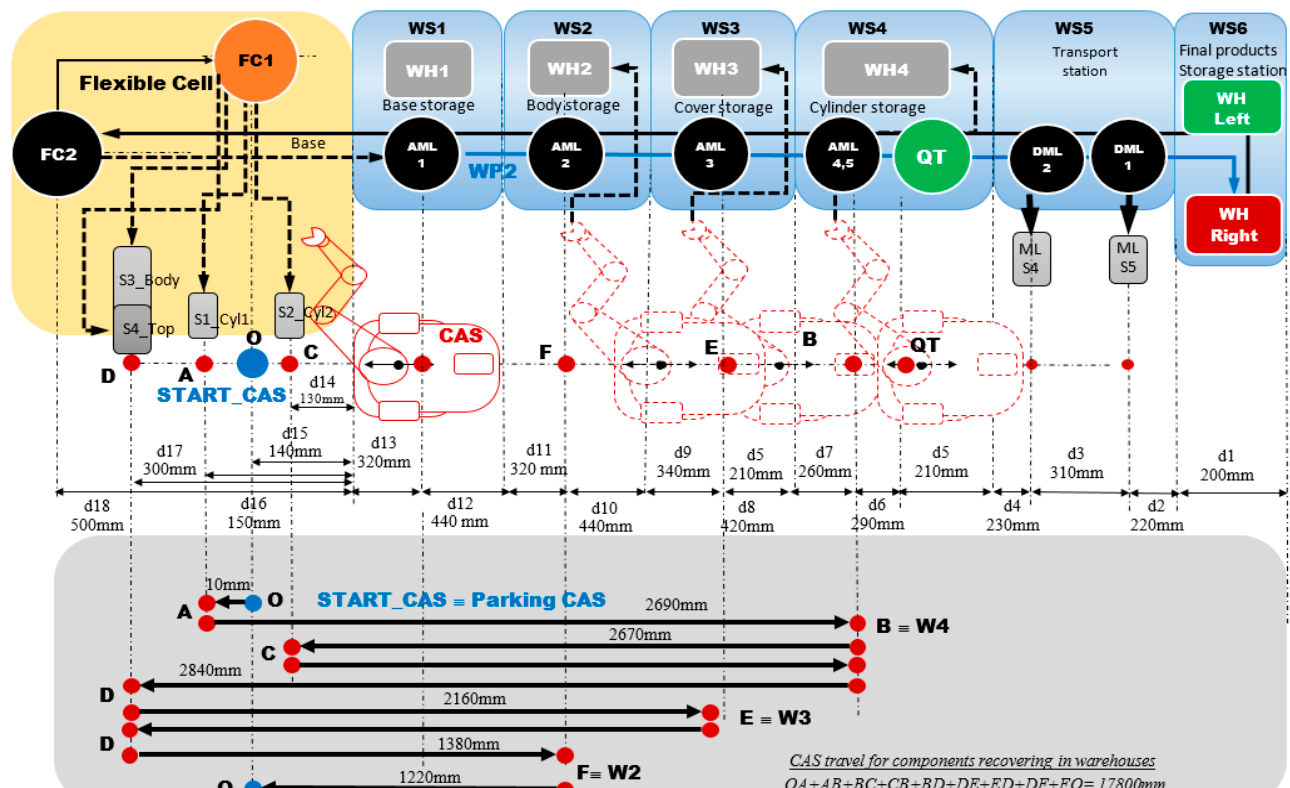
Figure 4. A/D/RML and distances traveled by CAS for part recovery corresponding to the disassembly function.